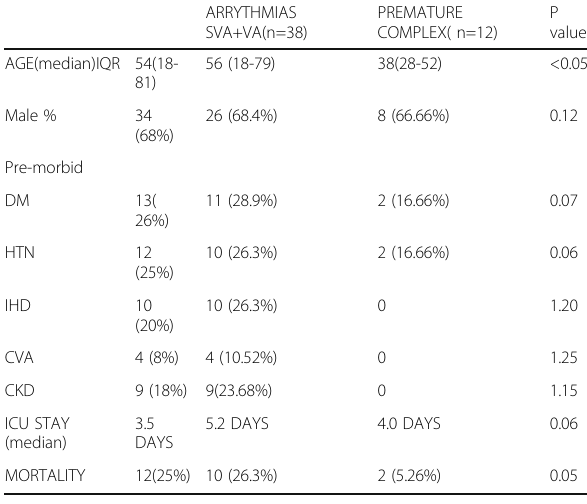
Table 1 (abstract 000665). Socio-demographic profile and select clinical variables of